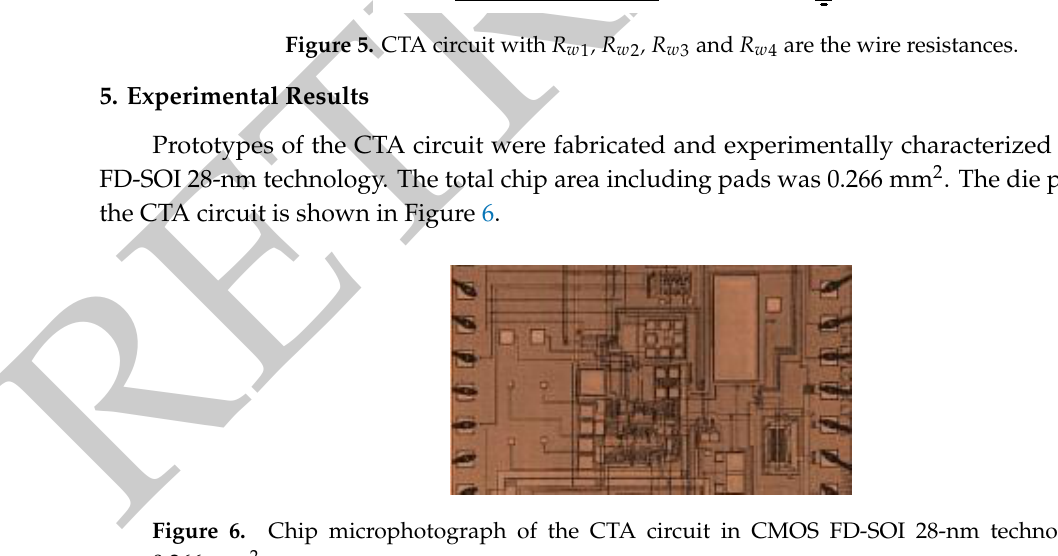
Chip microphotograph of the CTA circuit in CMOS FD-SOI 28-nm technology and 0.266- mm 2 area. Figure 6.